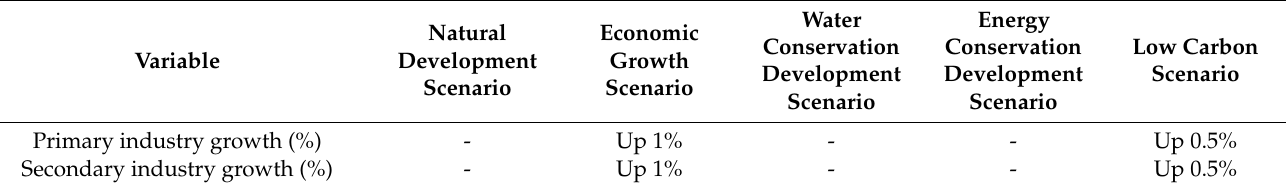
Table 3. Average annual adjusted rates of every variable in the five scenarios of the Hebei urban metabolic system simulation from